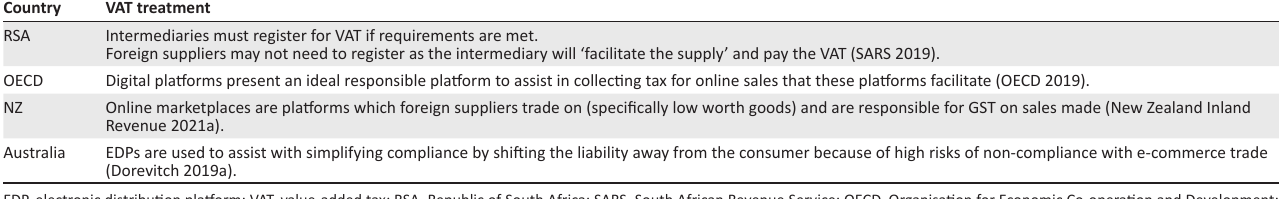
TABLE 8: A comparison of the liabilities of platforms to collect, assess and remit value-added Tax in Republic of South Africa, Organisation for Economic Co-operation and Development guidelines, New Zealand and Australia. Country VAT treatment RSA